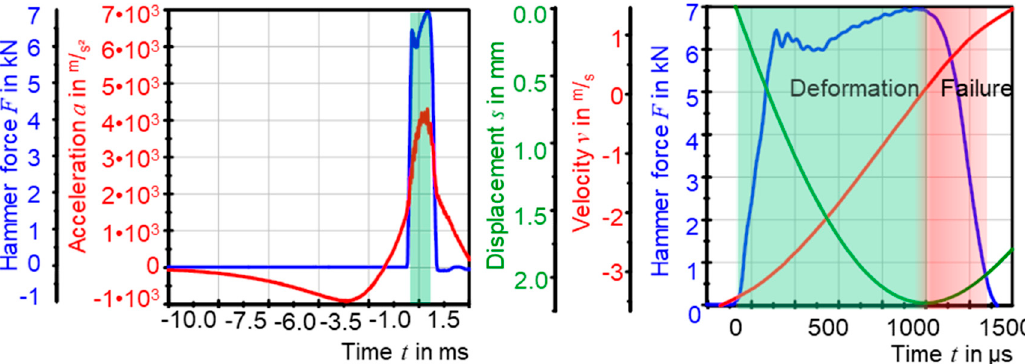
Figure 15. Deformation and load course measured on the pneumatically driven setup.